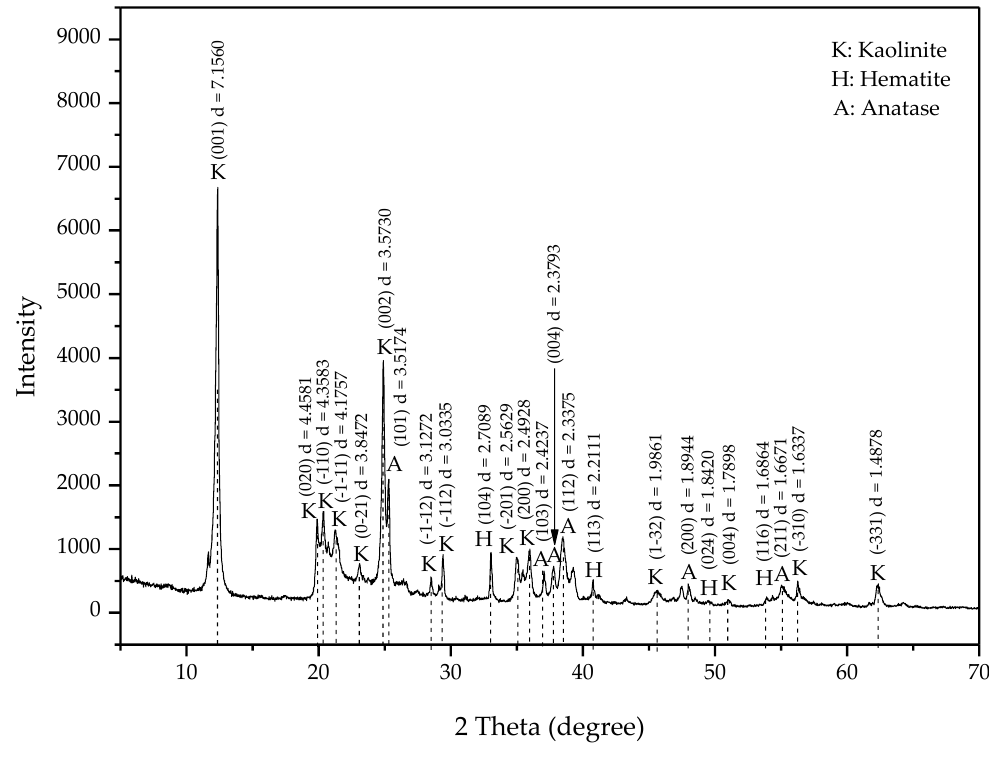
Figure 1. The X-ray diffraction (XRD) pattern of kaolinite-type pyrite flotation tailings (KPFT). Table 1. The chemical composition of kaolinite-type pyrite flotation tailings (KPFT) examined by X-ray fluorescence spectroscopy (XRF).